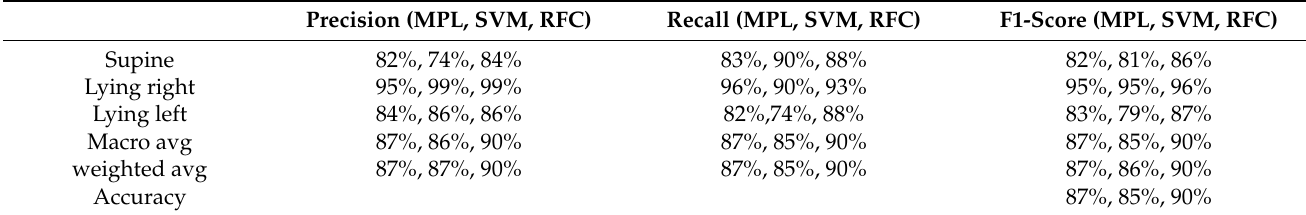
Table 2. Results obtained using the MPL, SVM, and RFC to predict new